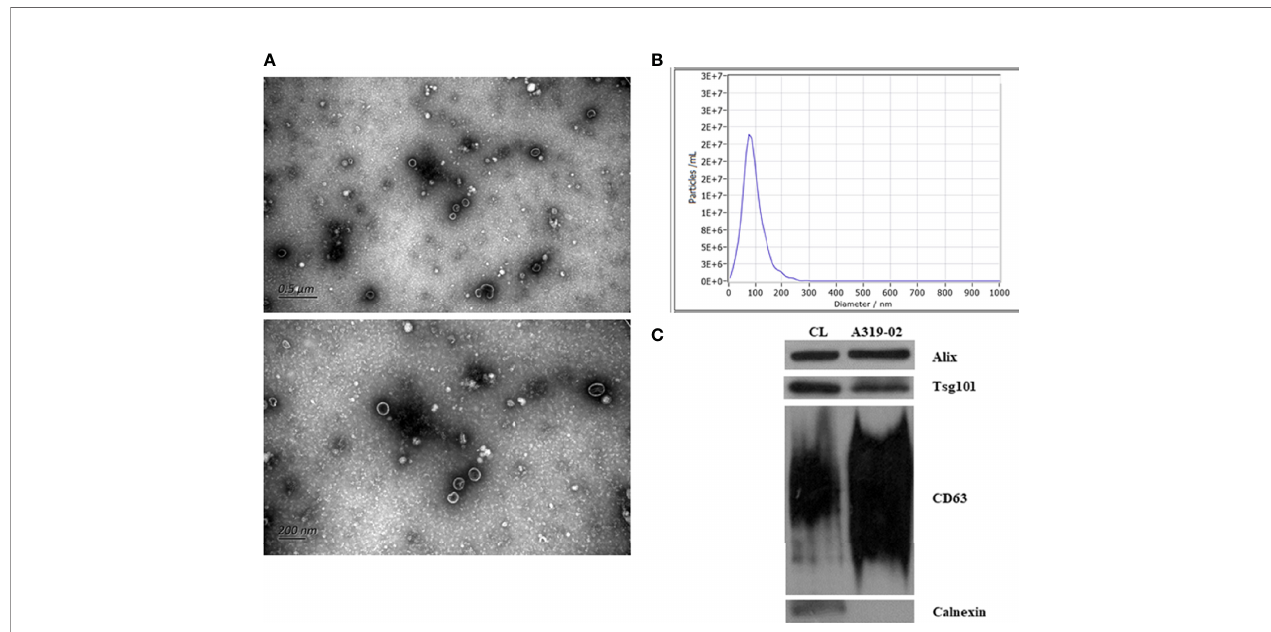
FIGURE 1 | Identi fi cation of exosomes. The transmission electron microscopy images of exosomes (A) . The size distribution of exosomes analyzed by nanoparticle tracking analysis (B) . Validation of marker proteins and negative protein of exosomes (C) .